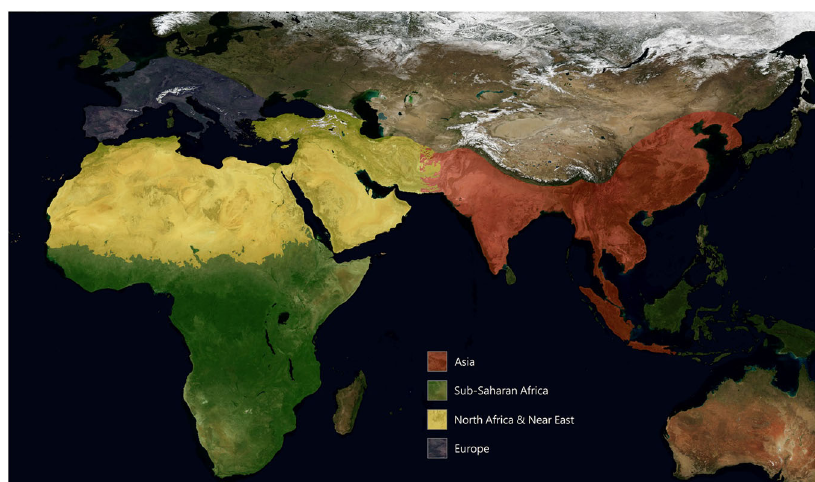
Fig. 2 The four continental regions of the Acheulean world examined in the present study (Green = Sub-Saharan Africa, Yellow = North Africa and the Near East, Blue = Europe, Red = Asia). As indicated in Fig. 1, not all areas currently have strong or continued evidence of the Acheulean being present (e.g. Congo River Basin). Original satellite image credit: NASA Visible Earth